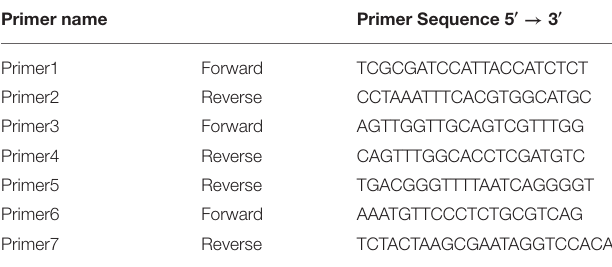
TABLE 1 | Primer sequences